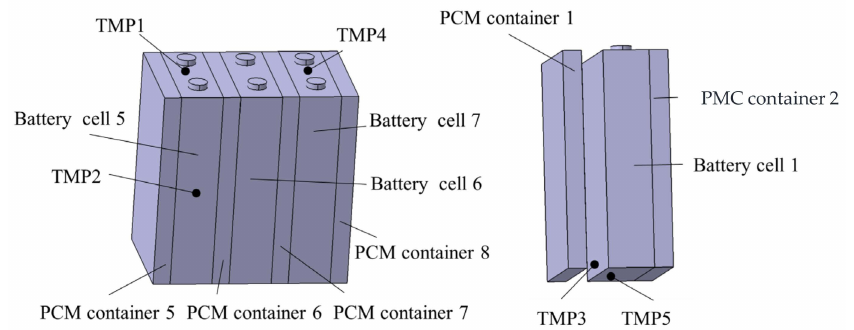
Figure 3. Temperature measurement point